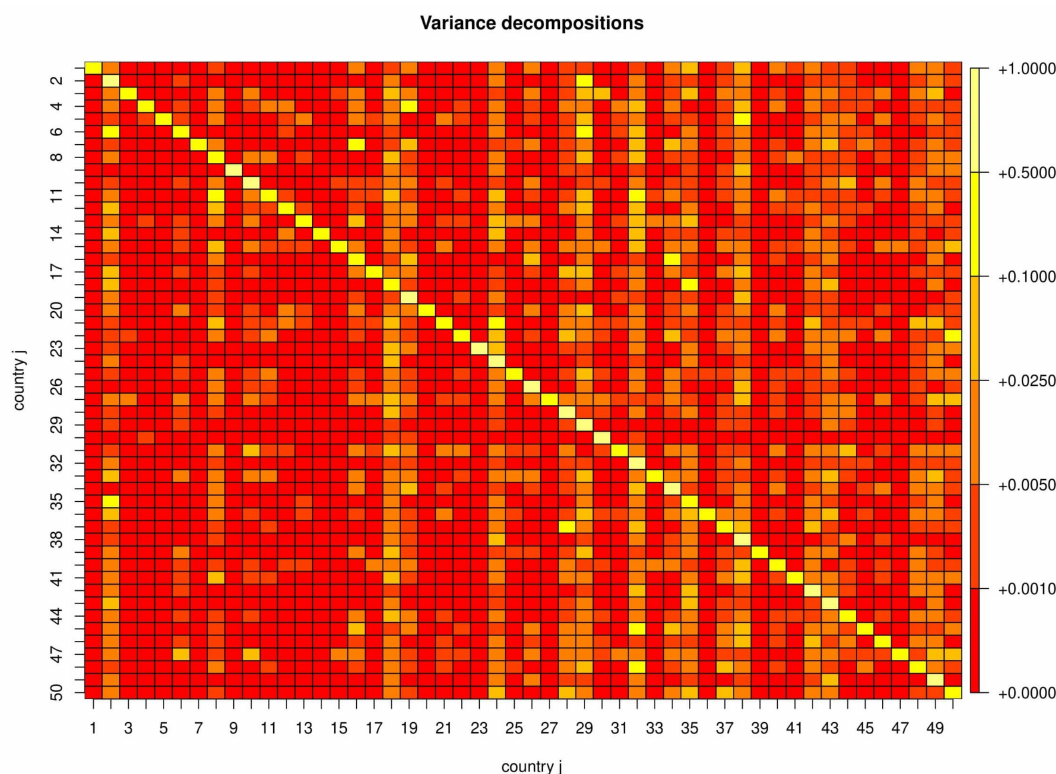
Figure 4. Decompositions of forecast